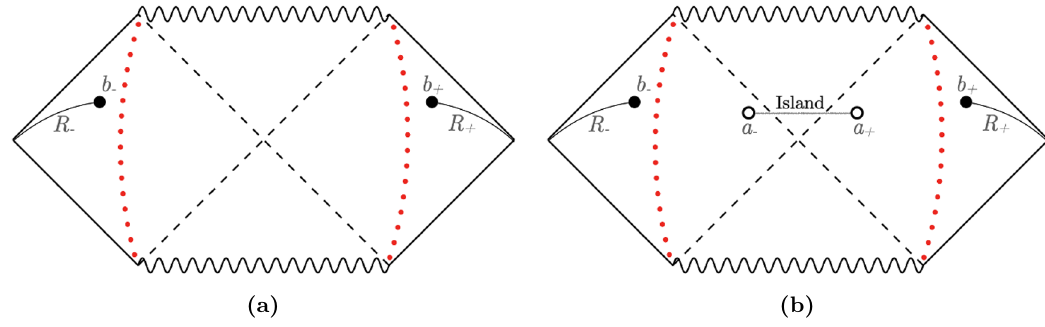
Figure 2. (a) Penrose diagram of the eternal linear dilaton black hole plus the matter fields in the absence of islands. The dotted red lines correspond to the fictitious boundaries of the regions outside of which the effect of the matter sector on the geometry — and vice versa — can be safely neglected. The black lines are the entanglement regions R ∓ where the radiation lives and b ∓ denoted by blobs their respective boundaries. Their ranges are ( −∞ , b − ] and [ b + , + ∞ ) , respectively; the radiation region is therefore R = R − ∪ R + = ( −∞ , b − ] ∪ [ b + , + ∞ ) . (b) The Penrose diagram of the same system in the presence of an island with boundaries located at a ∓ . Note that for the eternal black hole, the island’s boundaries lie outside the horizon [9, 15,